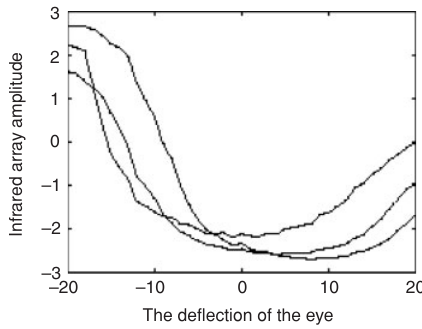
Figure 12 The block diagram of EOG-based eye movement detection system. Figure 13 The eye movement record in tracking target.